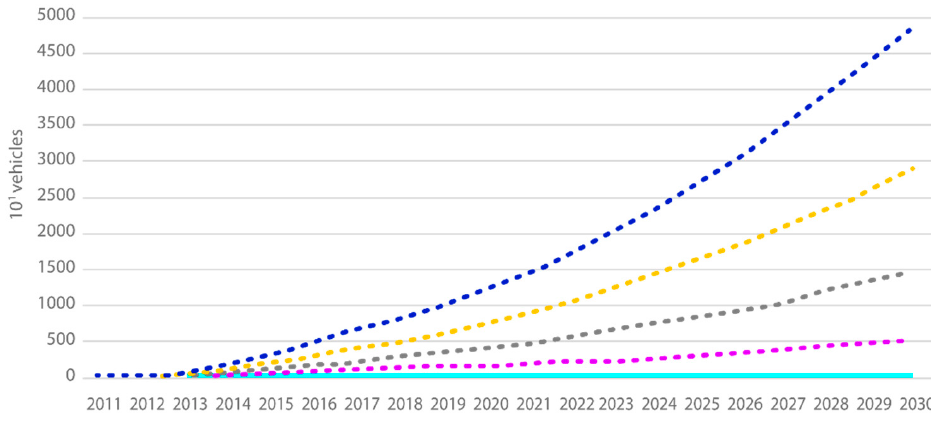
Figure 4. Prediction of the fleet of BEVs, HEVs and PHEVs.